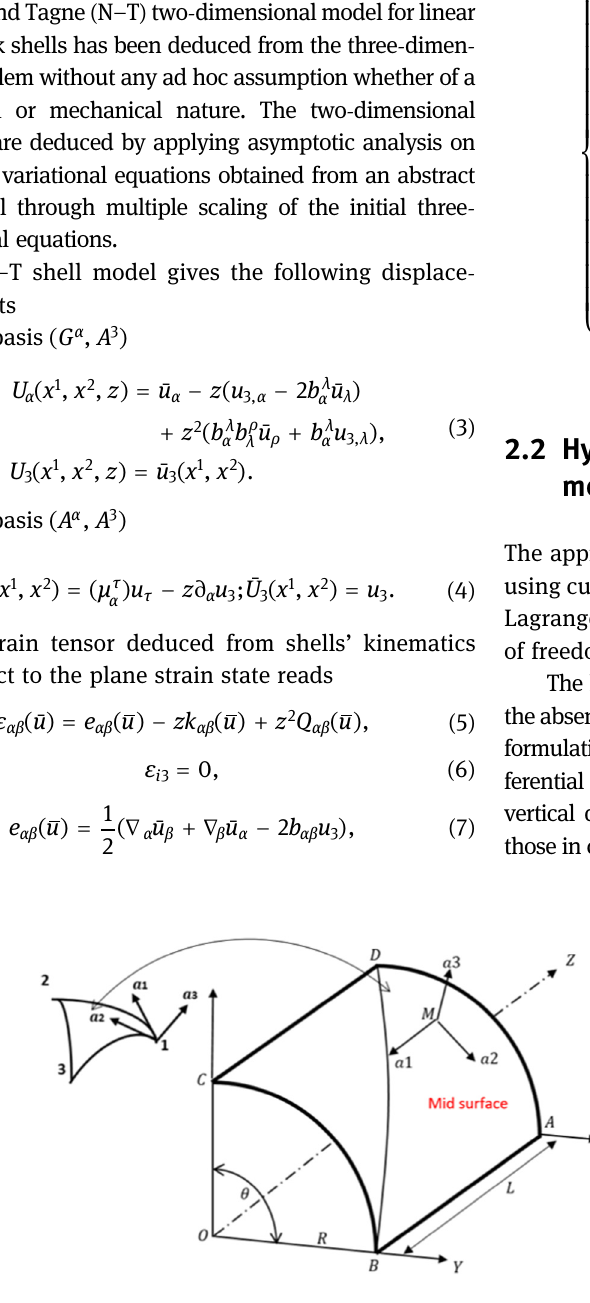
Figure 1: Triangular shell